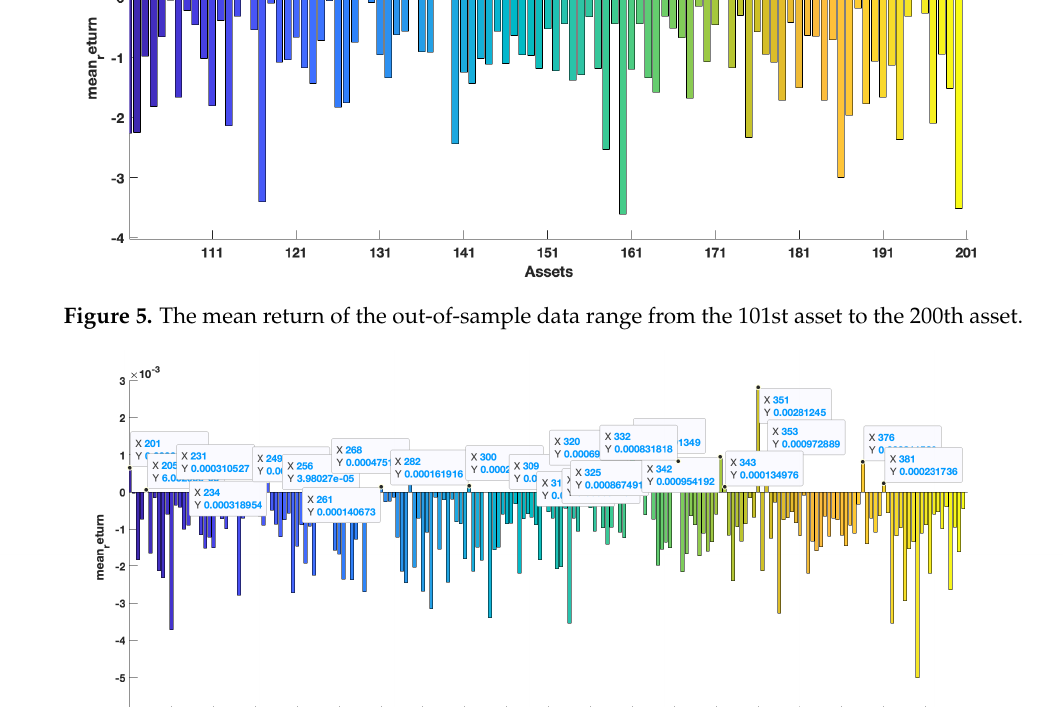
Figure 6. The mean return of the out-of-sample data range from the 201st asset to the 400th